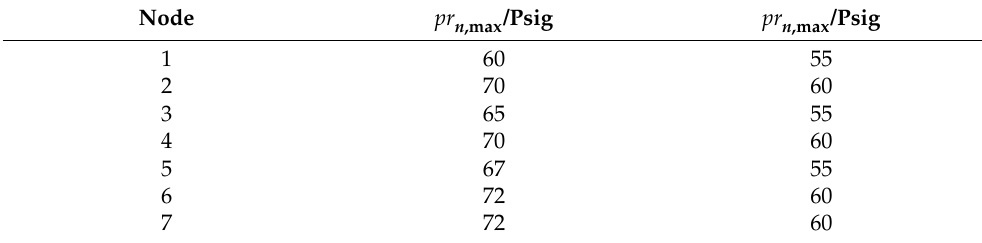
Table A7. Parameters of natural gas